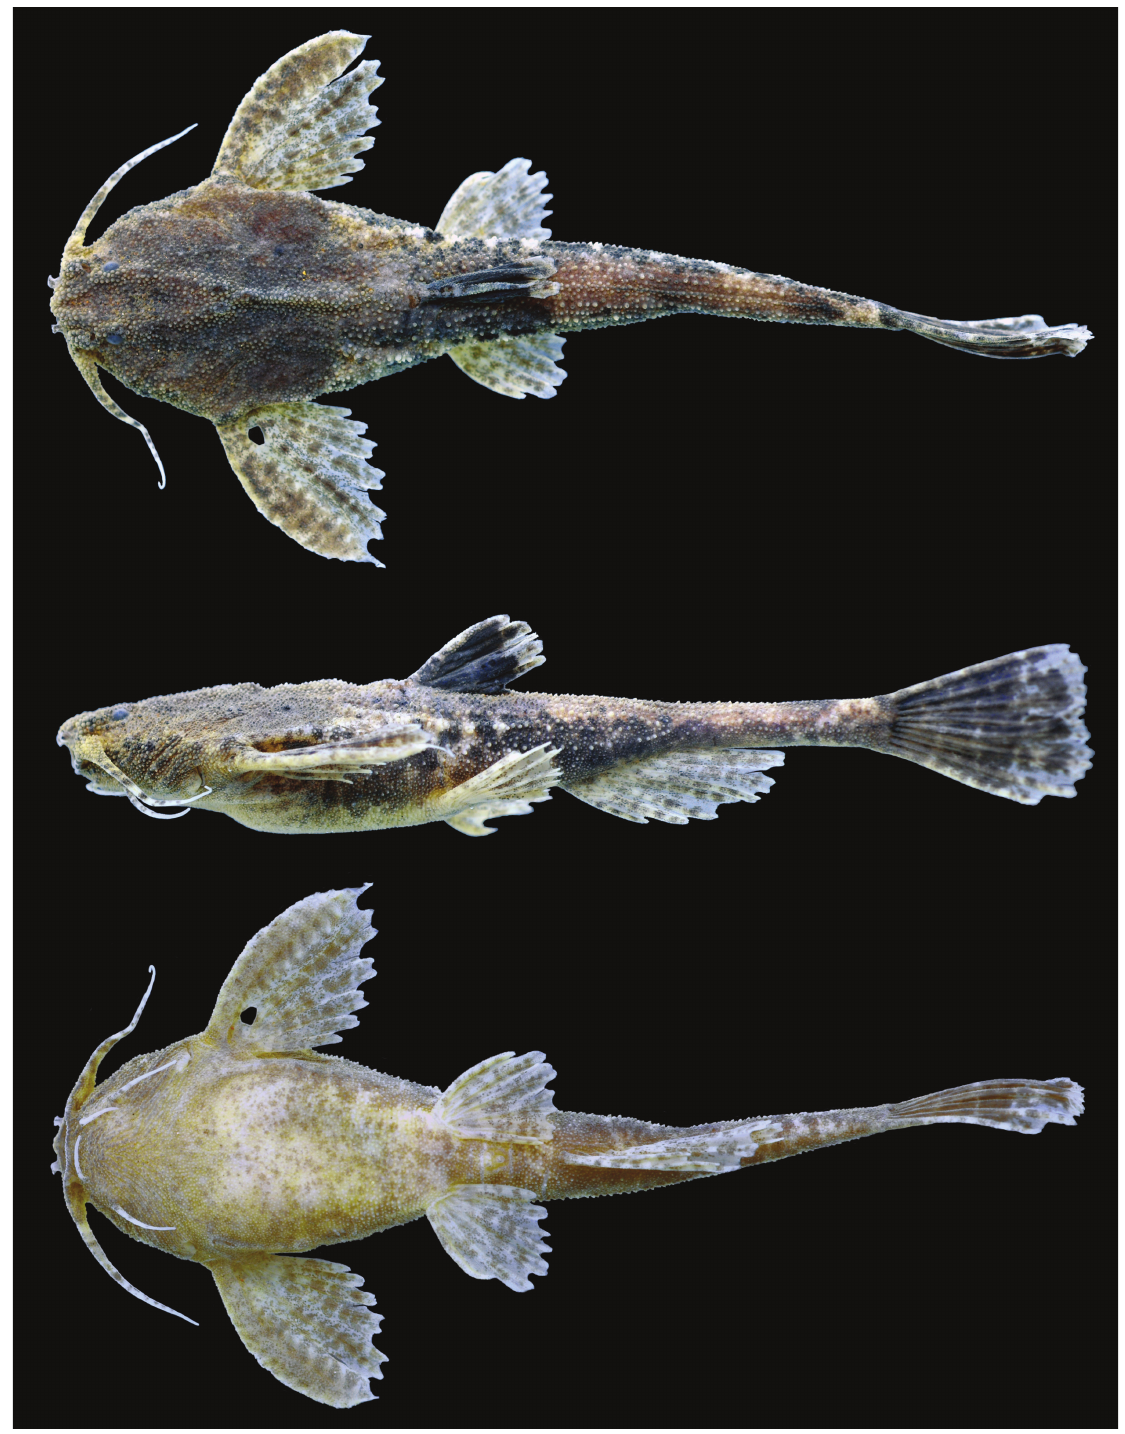
Fig. 5. Bunocephalus minerim , MCP 47087, holotype, 37.9 mm SL, córrego Guarda-Mor near the town of Guarda-Mor on highway BR-364, Minas Gerais,